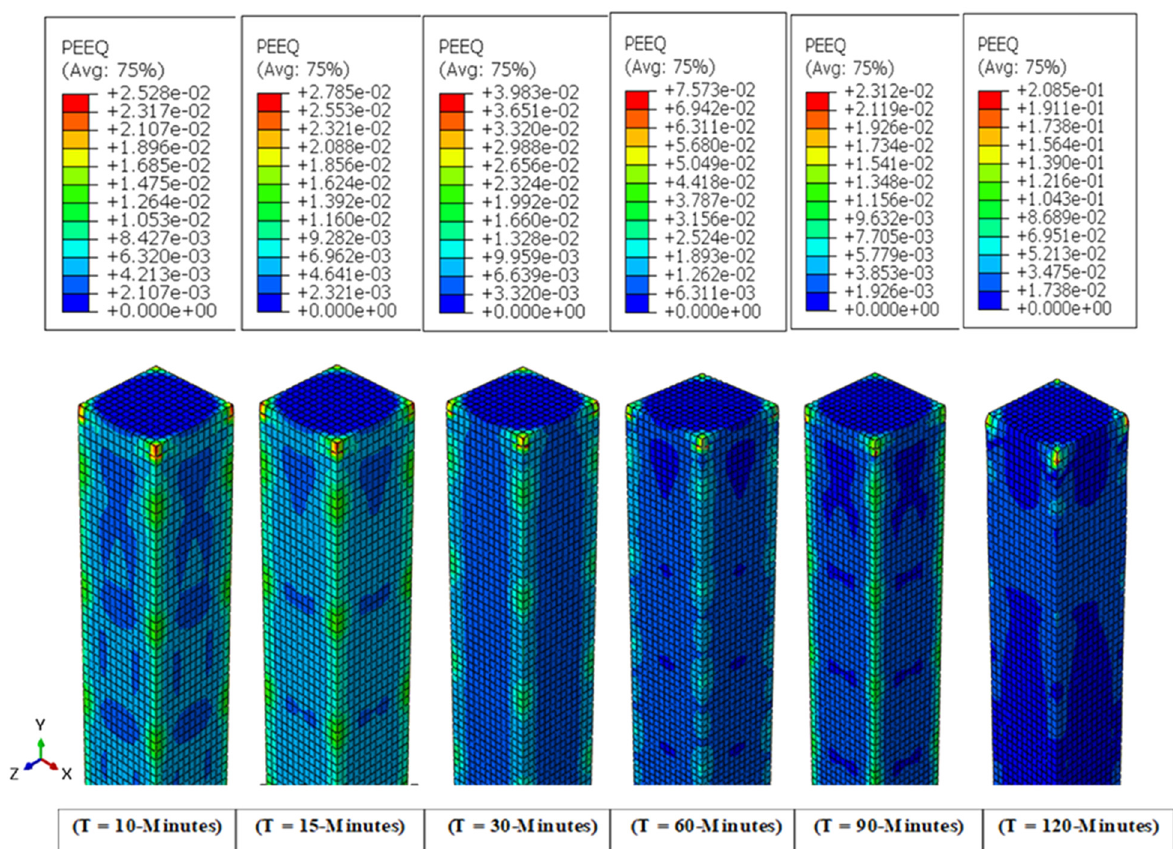
Figure 14: Equivalent plastic